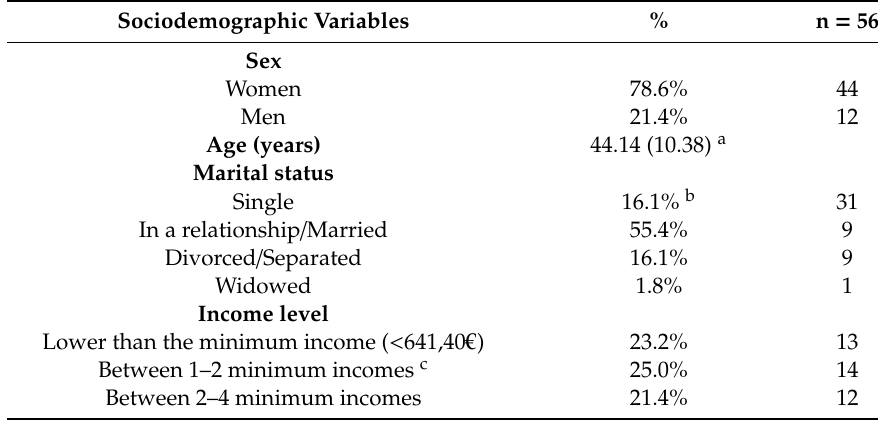
Table 2. Sociodemographic characteristics of the